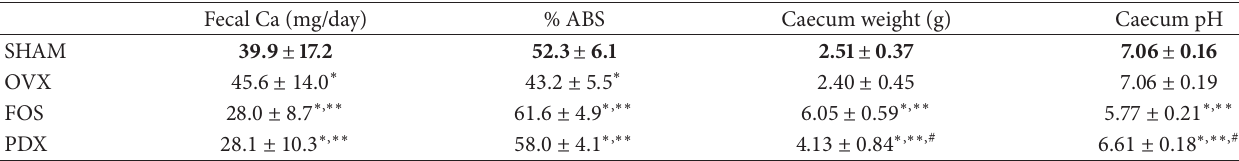
Table 3: Daily fecal Ca excretion, percentage of apparent Ca absorption (% ABS) during the last three days of the experiment, and caecum weight and caecum pH at the end of the study.